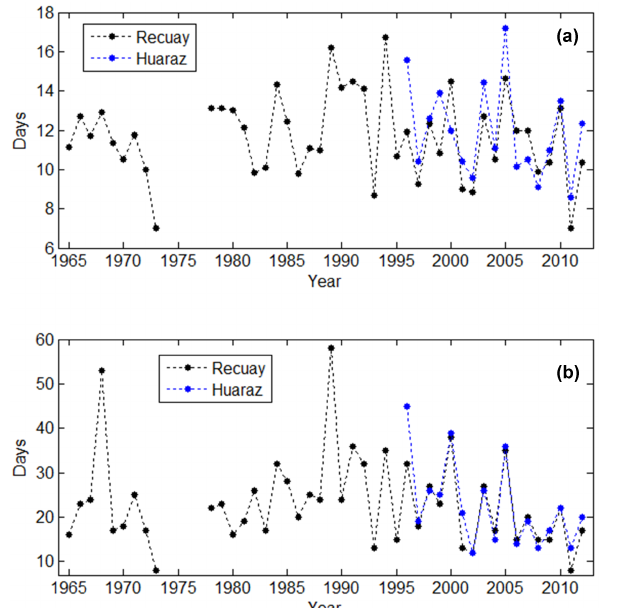
Figure A1. (a) Mean and (b) maximum length of dry periods (consecutive dry spells as defined in Sect. 4.2) for each agricultural year between 1 August and 23 April (earliest calculated onset of dry season) in Recuay and Huaraz.